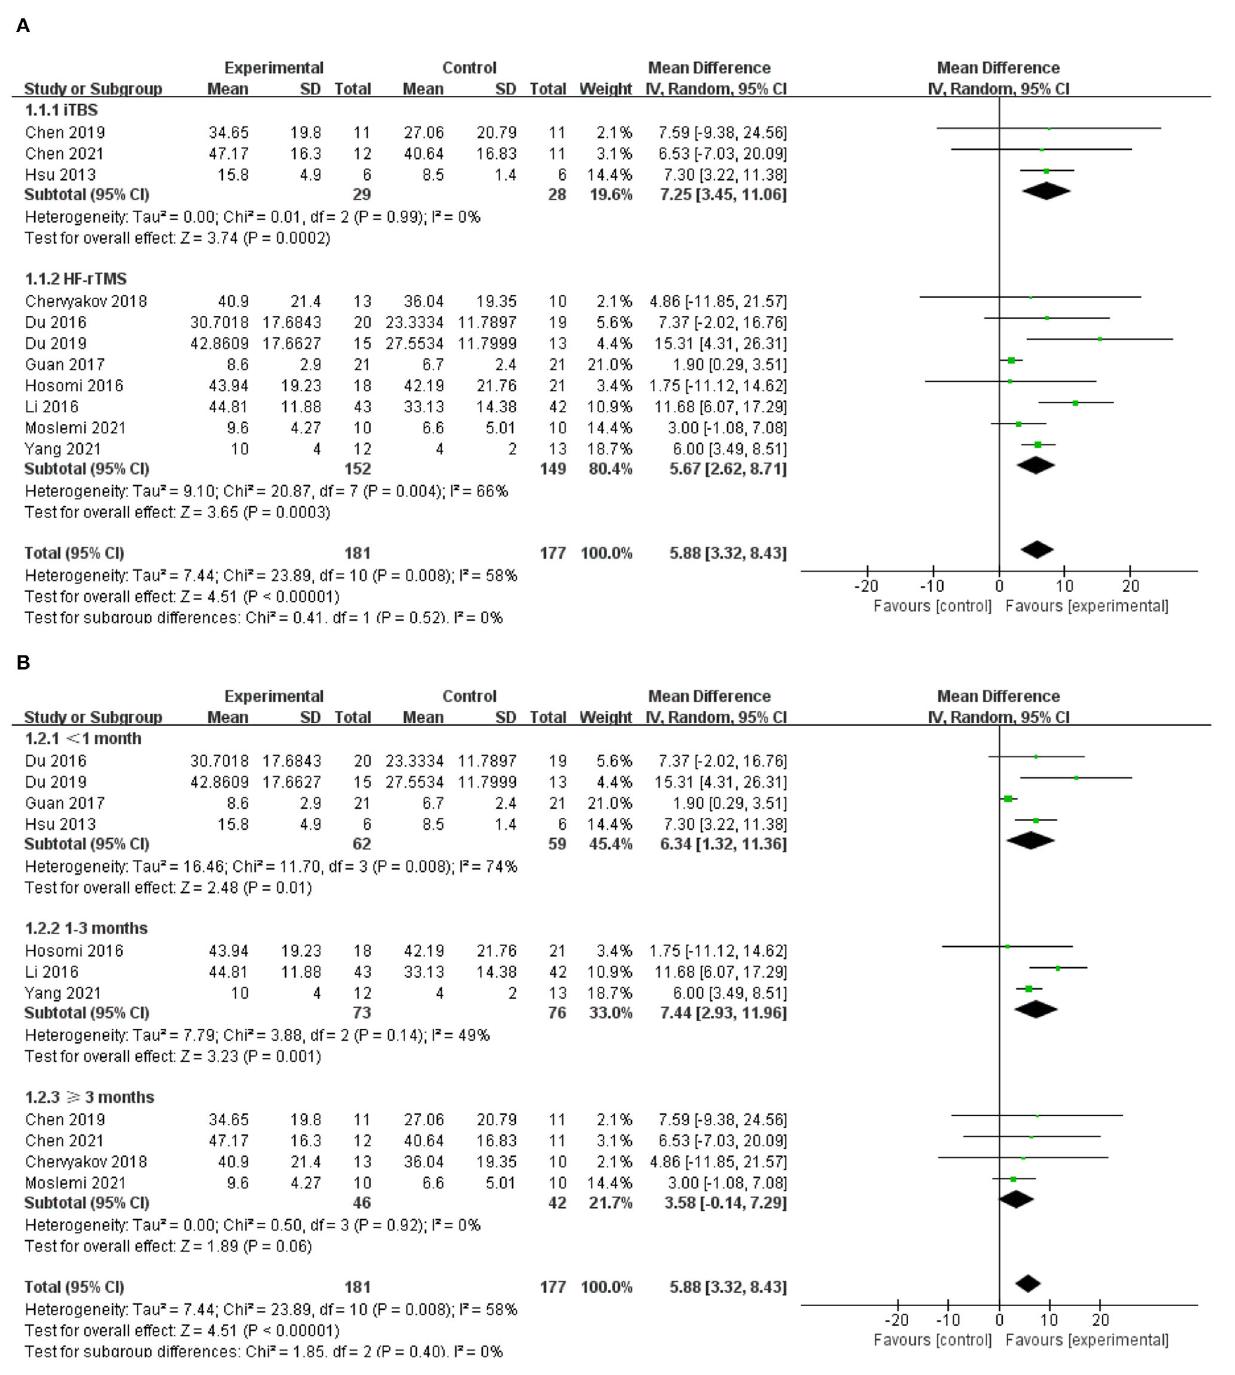
hemisphere on upper limb motor recovery after stroke.